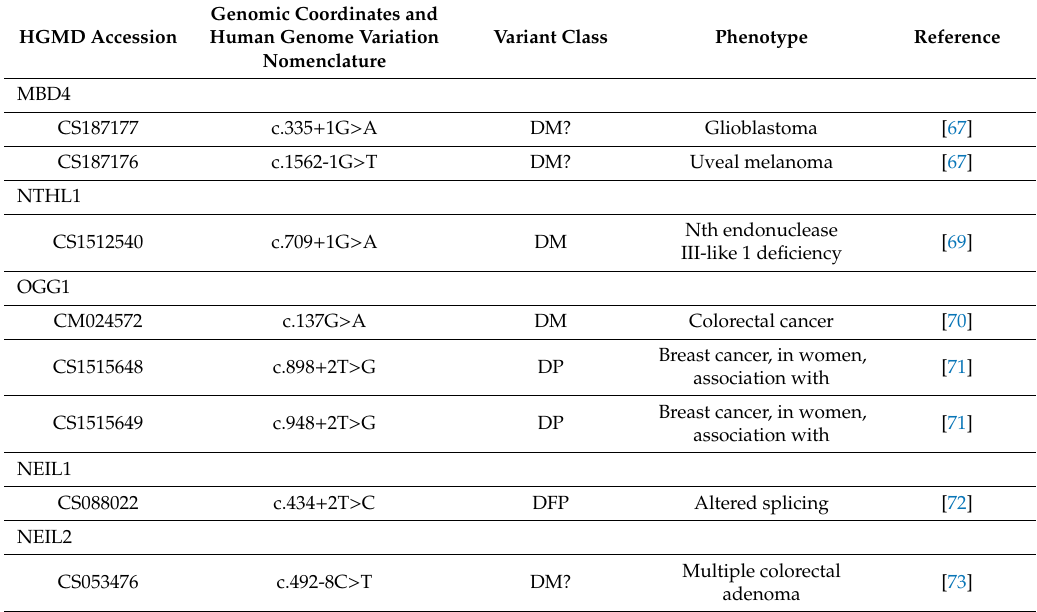
Table 2. Pathogenic splice variants of MBD4 , NTHL1 , OGG1 , NEIL1 , and NEIL2